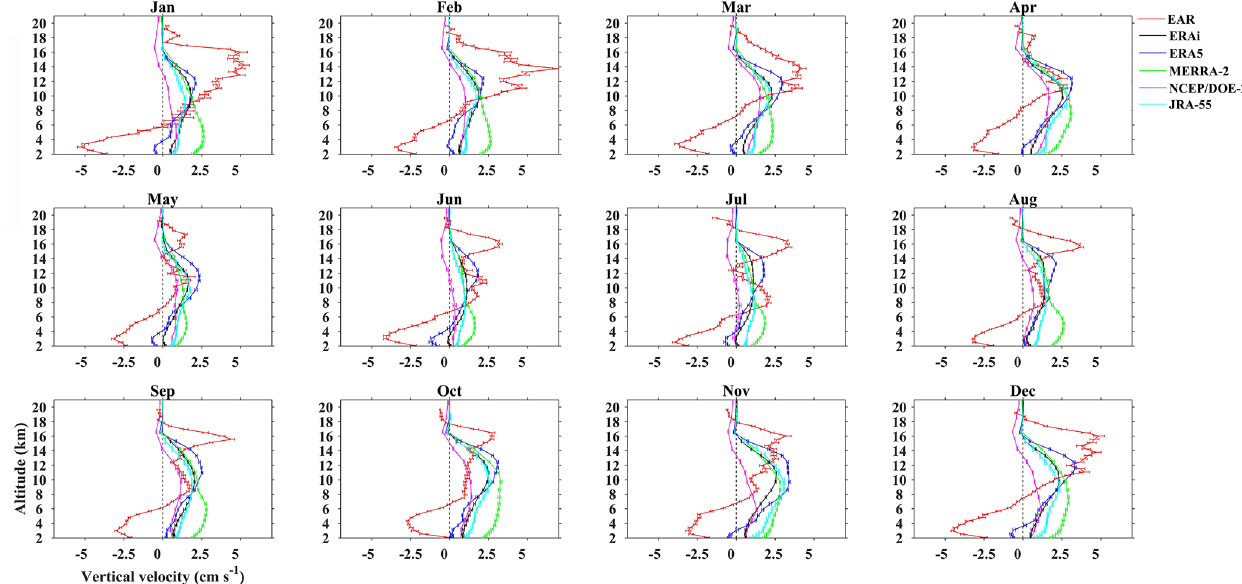
Figure 5. Same as Fig. 4 but from EAR over Kototabang from 2001 to 2015.